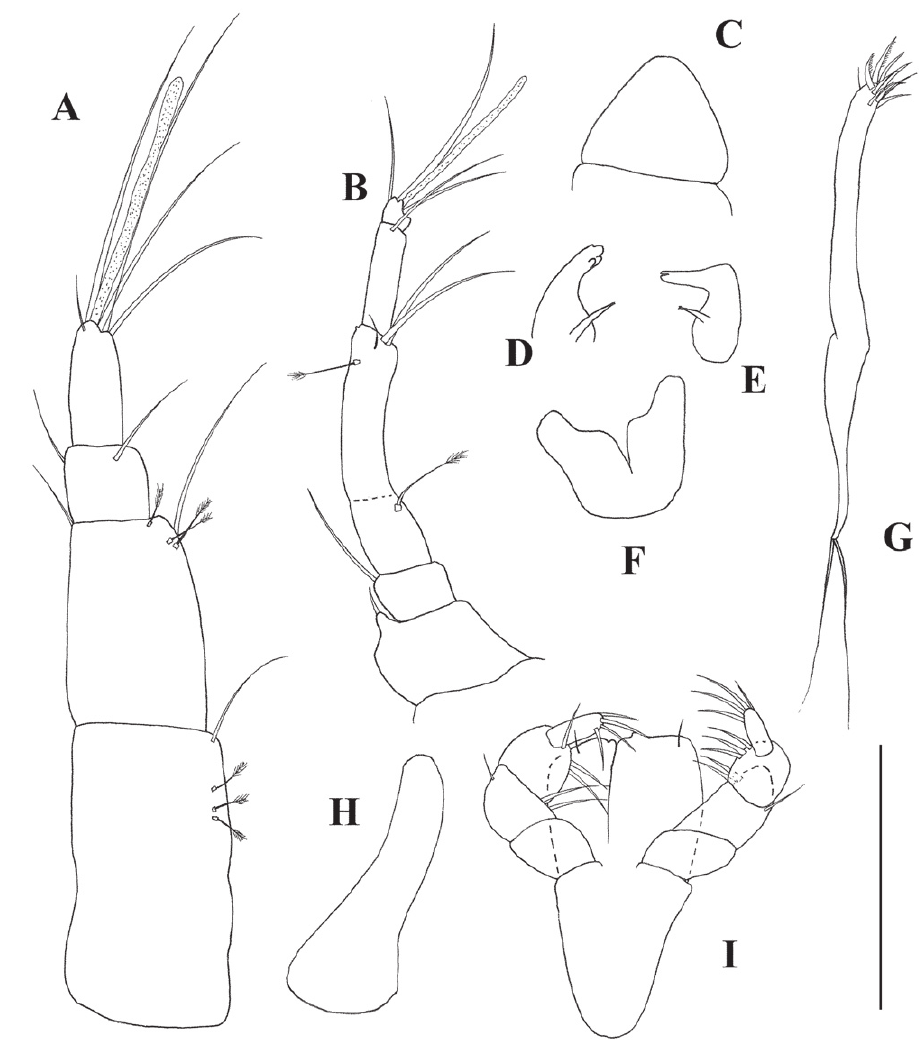
Figure 6. Tumidochelia tuberculata sp. n. Holotype A antennule B antenna C labrum D right mandible E left mandible F labium G maxillule H maxilla I Maxilliped. Scale bar 0.1 mm.